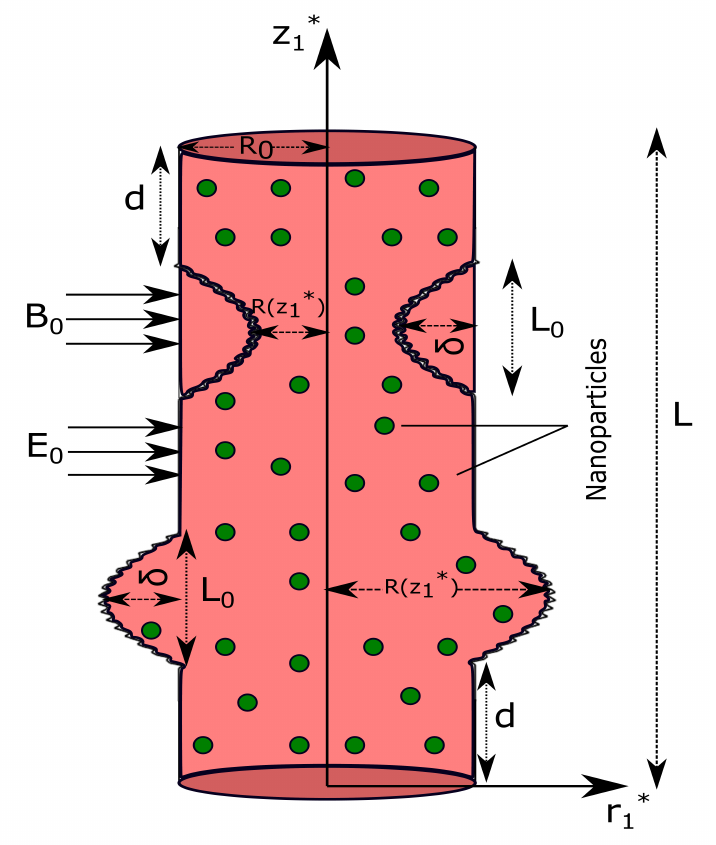
Figure 1. Physical sketch of artery with time variant stenosis and